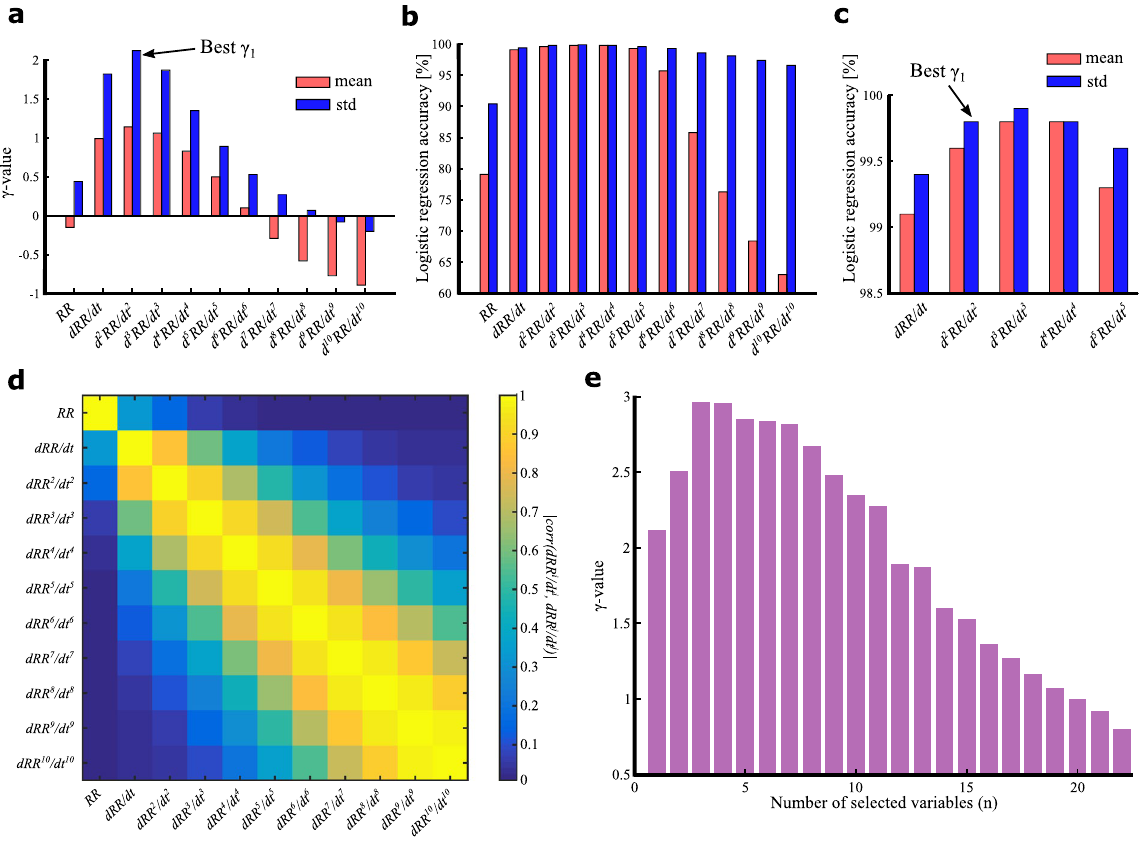
Figure 4. Optimizing state characterization using the γ -metric. ( a ) γ -values for the mean and standard deviation operators applied to 1-min RR interval time series and their first ten derivatives for Normal Sinus Rhythm (NSR, N = 4,500) and Atrial Fibrillation (AF, N = 2,900) states. ( b ) Percentage accuracies for the subsequent univariate logistic regression classification of 7,400 heart rhythm states with respect to the operators (mean and standard deviation) and time derivatives used to characterize the 1-min RR interval time series. ( c ) Zoomed-in view of the cases with the highest accuracy depicted in ( b ). The best γ 1 selection is noted for comparison with the subsequent best classification accuracy. ( d ) Correlations between the 11 time series used to characterize the heart rhythm states (the RR interval time series and its first ten derivatives) expressed as a matrix of the absolute values of the Pearson correlation coefficients. ( e ) Highest γ -values for all n-variable combinations of the generated variables (means and standard deviations of the RR interval time series and each of the first ten derivatives). This multivariate γ -analysis indicates that the maximum discriminatory power (highest γ -value) is achieved with three